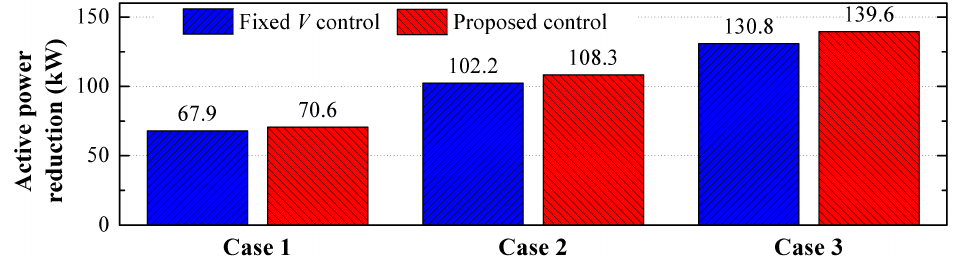
15 of 17 Figure 12. Average reduction of the active power drawn from substation: two ‐ DG system. 5.3. Five ‐ DG System Three cases were tested according to the load level. The power consumption of each load for Cases 1, 2, and 3 was 70%, 100%, and 130% of the original value, respectively. For the output pattern of DGs, the same PDF as that of Case 3 of the two ‐ DG system with the maximum power of 1000 kW was used. The expected active power output was 727.3 kW. In this case study, the results with the proposed method were only compared to those with the FV method. In order to identify the voltage control capability, the minimum voltage was obtained by increasing the active power output of each DG by 100 kW. Even though the number of DGs increased, the voltages of the test system were maintained as greater than or equal to the lower bound in all three cases. Only the simulation results for Case 2 are shown in Figure 13 due to limited space. With the FV method, the minimum voltage at the expected operating point was 0.9566 p.u. and the minimum voltage was equal to the lower bound when the active power output of the DG connected to node 66 was maximum and the active power outputs of the other DGs were minimum (i.e., the total active power output was 1,000 kW). However, with the proposed method, the minimum voltage was identical to the lower bound at the expected operating point. ( a ) ( b ) Figure 13. Minimum voltage according to the total active power output of DGs: Case 2 for Five ‐ DG